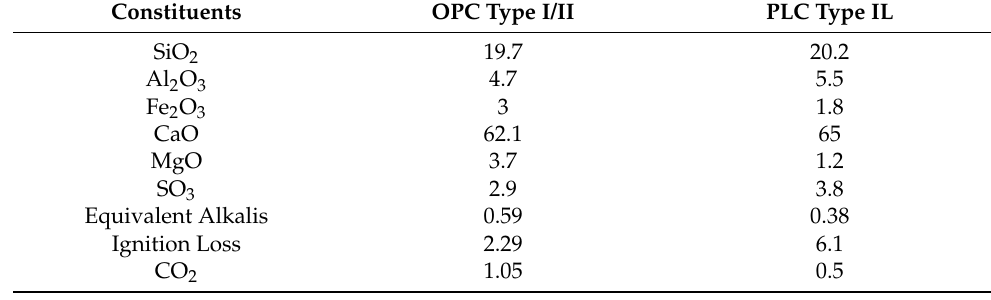
Table 1. Chemical composition of Ordinary Portland Cement (OPC) and Portland Limestone Cement (PLC) (% by weight).